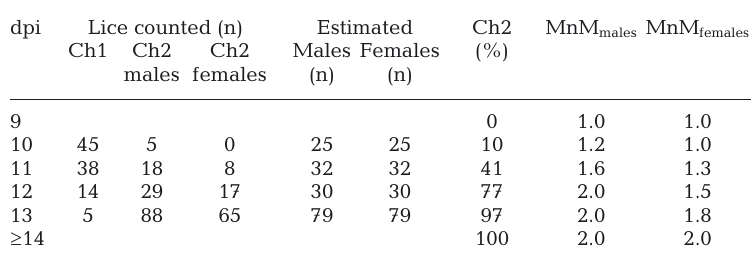
Table 1. Distribution of male and female Lepeophtheirus salmonis among the chal- imus (ch) stages during the phase when the population molts from ch I (ch1) into the ch II (ch2) stage at 10°C (unpublished details from experiments reported by Eichner et al. 2018). The table shows the number and stage of lice counted and sex of the ch2. The overall number of males and females present in the samples is estimated under the assumption that there is a 1:1 male:female distribution. Mean number of molts (MnM) is estimated by MnM males = 1 + (ch2 males /males) and MnM females = 1 + (ch2 females /females) for males and females, respectively. dpi: days post